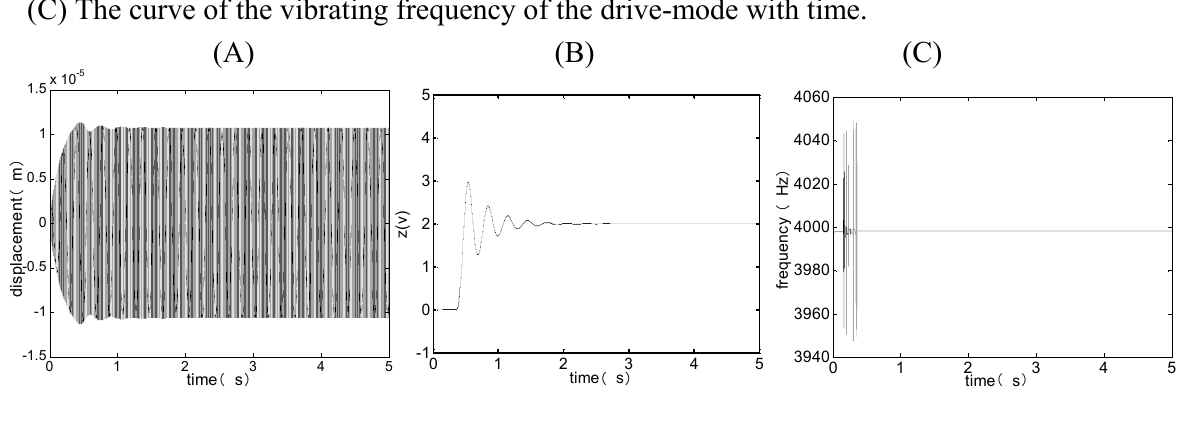
V V   . (A) The curve ref refo